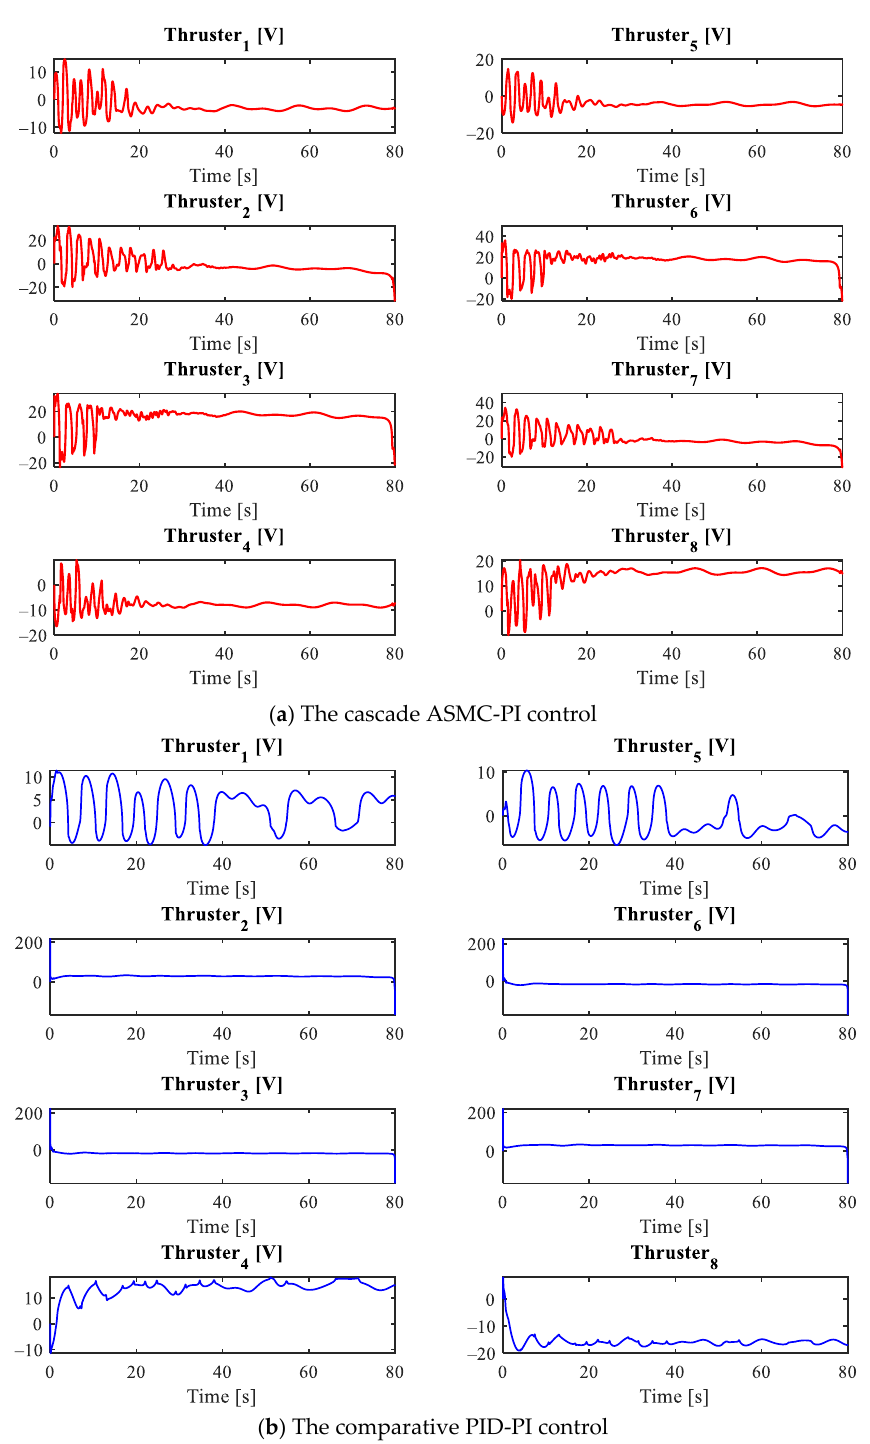
Figure 10. Control inputs of the ROV in the approaching